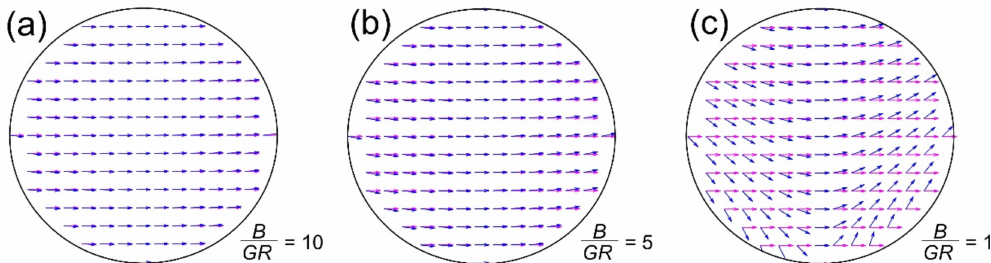
Figure 5. Schematic representation of the effect of concomitant gradients or violating Equation (7). Shown is the force over the internal area with a radius R for different ratios B /( GR ), cf. Equation (7). The magenta-colored arrows ignore the (cid:42) (cid:42) m always points along B (as in Equation (6), while the blue arrows account for the full field. This shows local field and the increasing deviation from a homogeneous force direction with increasing gradient and/or distance from the